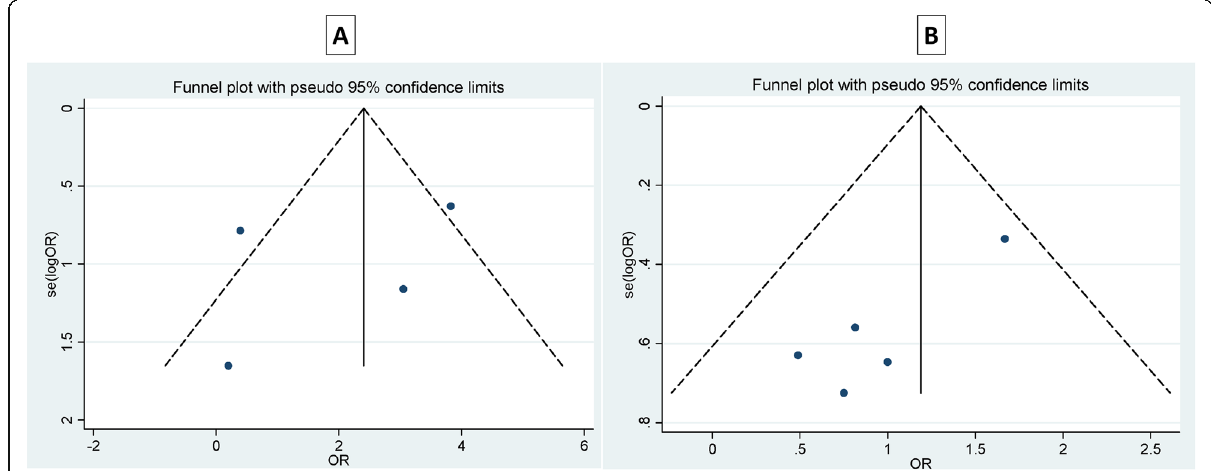
Fig. 4 Funnel plot. The plot displays publication bias and heterogeneity results between studies for ( a ) 2DP1 and ( b ) 3DL1 genes